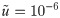
Probability of observing only one allele in a finite sample.(a) The probability Phard(j) of observing a hard (i.e. monoallelic) sweep in a sample of size j chosen at random from the range, computed from simulated clone size distributions for different dispersal kernels (colours, labeled) with L = 106 and u˜=10-6 in 1D. Three analytical forms are shown as dotted lines (from top to bottom): the Ewens’ sampling result for the panmictic case, the approximate form derived using a hard-cutoff ansatz for the allele frequency spectrum for μ = 1 (S1 Appendix, Eq (A12)), and Phard calculated from the exact f(x) for the wavelike spreading limit (S1 Appendix, Section G). (b) The same quantity computed across a range of rescaled mutation rates (symbols), and scaled by the expectation for a range with all clones having the same size and hence the same frequency Xave/L.